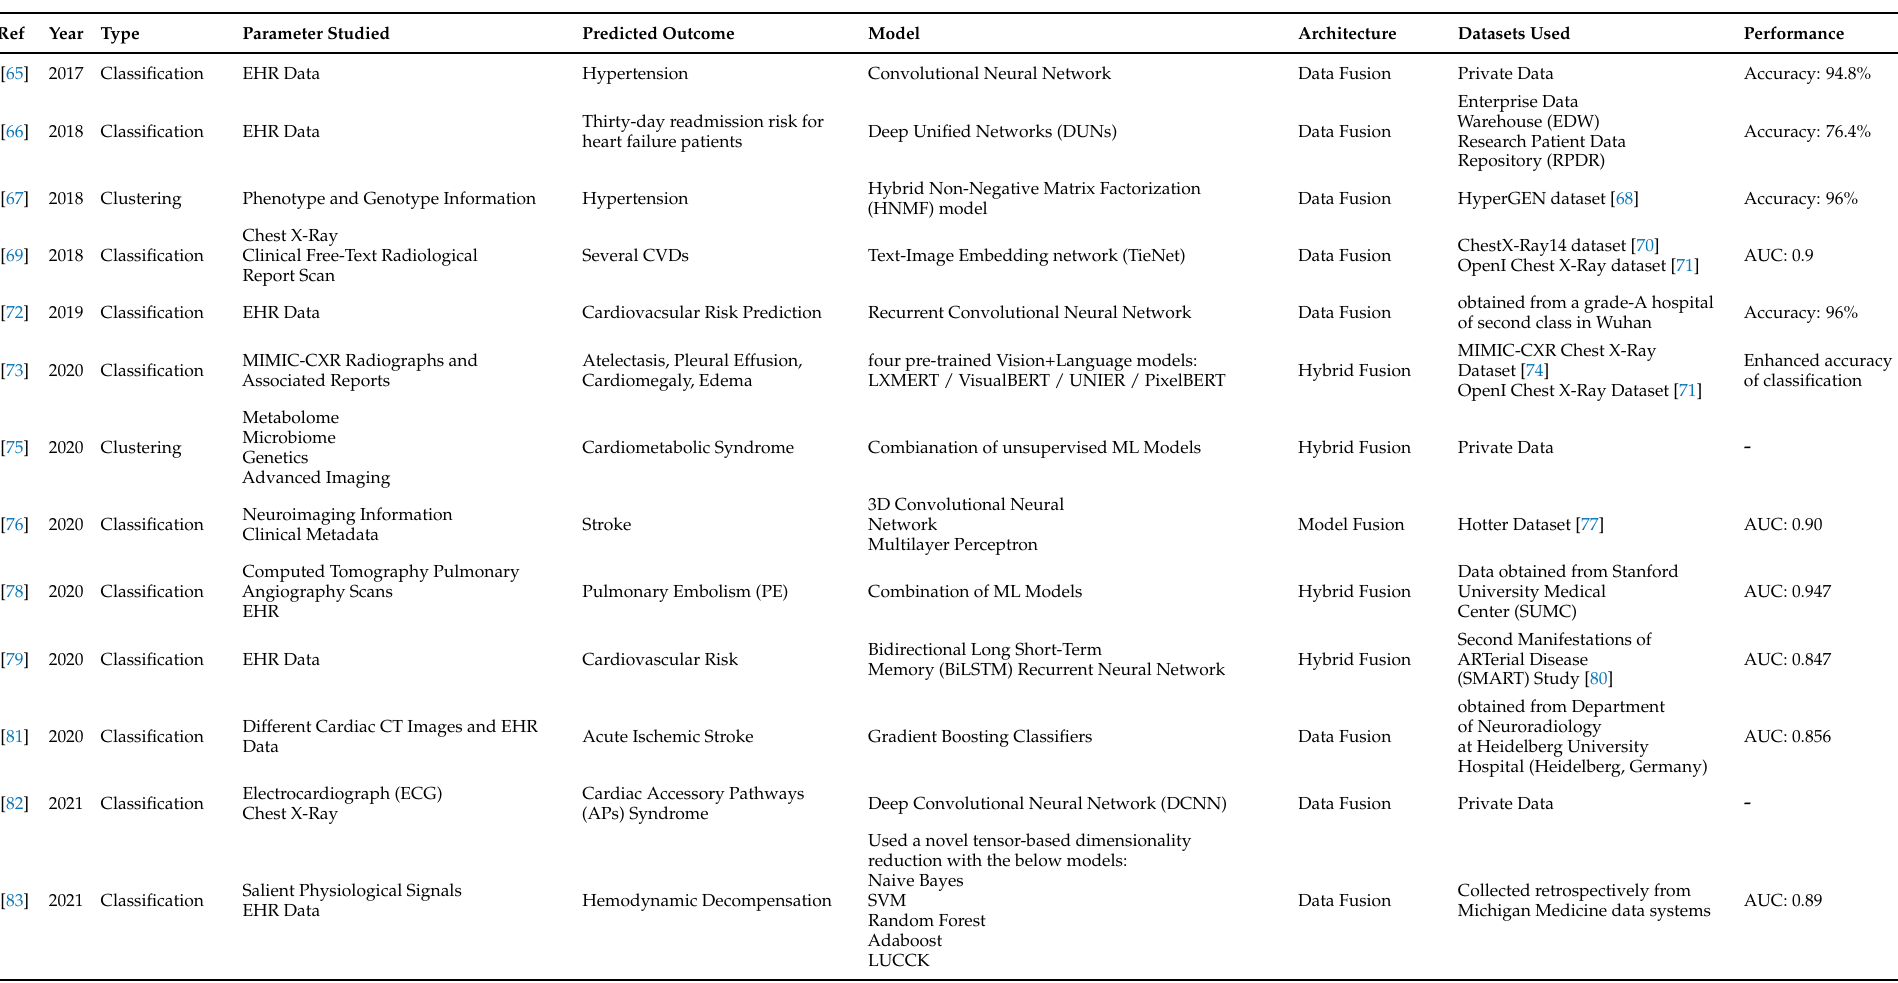
Table 4. Multimodal ML implementations in Cardiovascular Disease diagnosis and